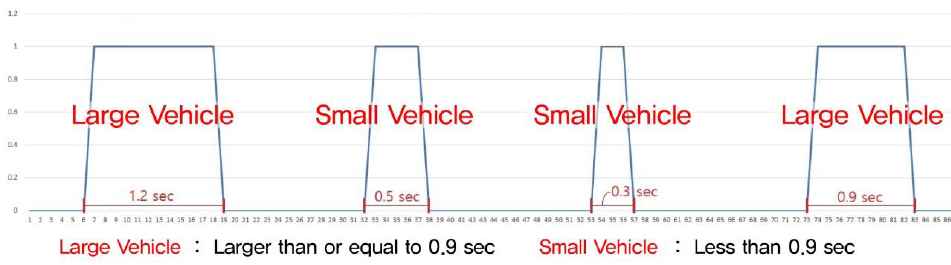
Figure 9. Threshold to classify vehicle types.